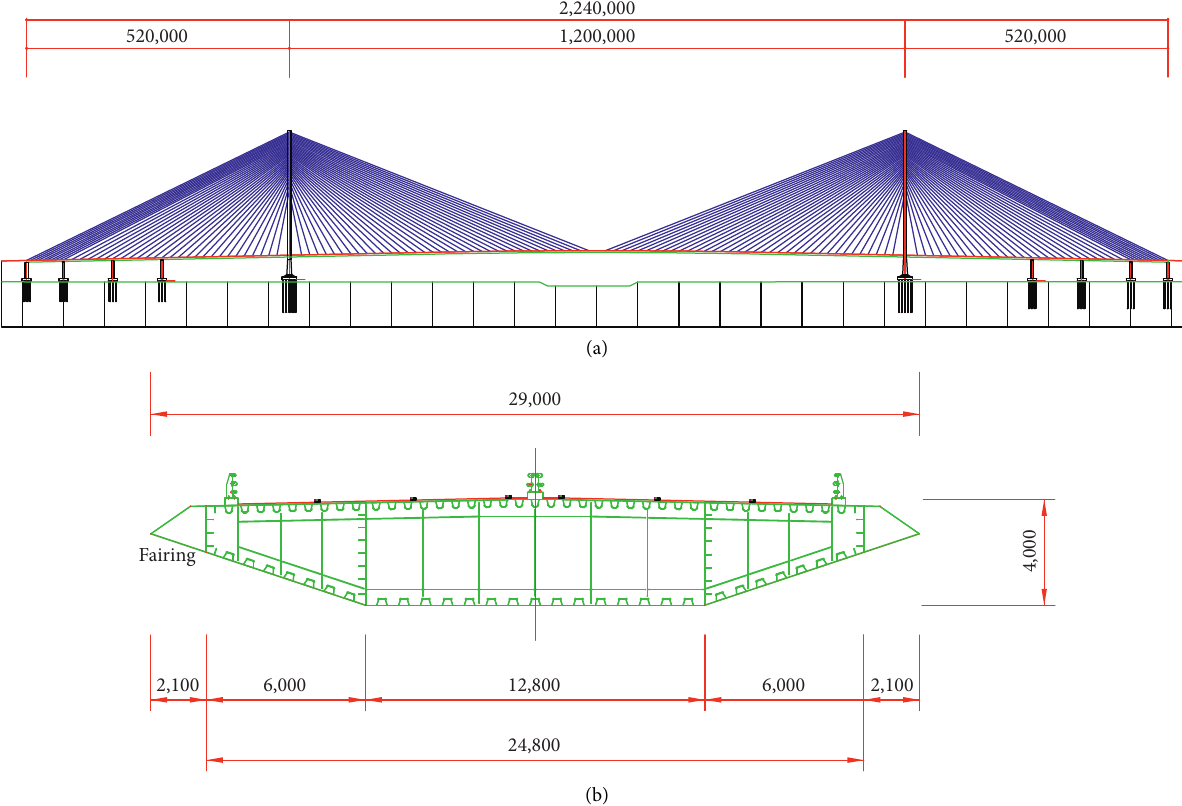
Figure 4: Target bridge and section (unit: mm): (a) dimensions of the bridge and (b) dimensions of the cross